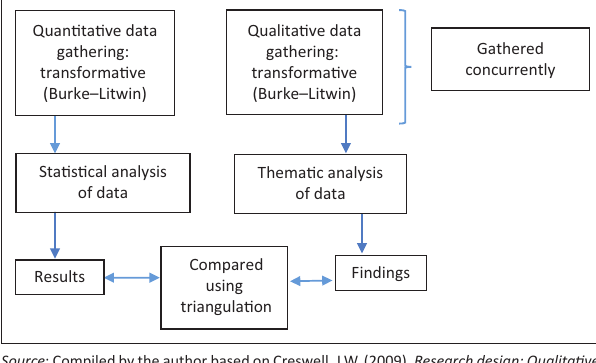
FIGURE 3: A visual exposition of the concurrent transformative strategy with